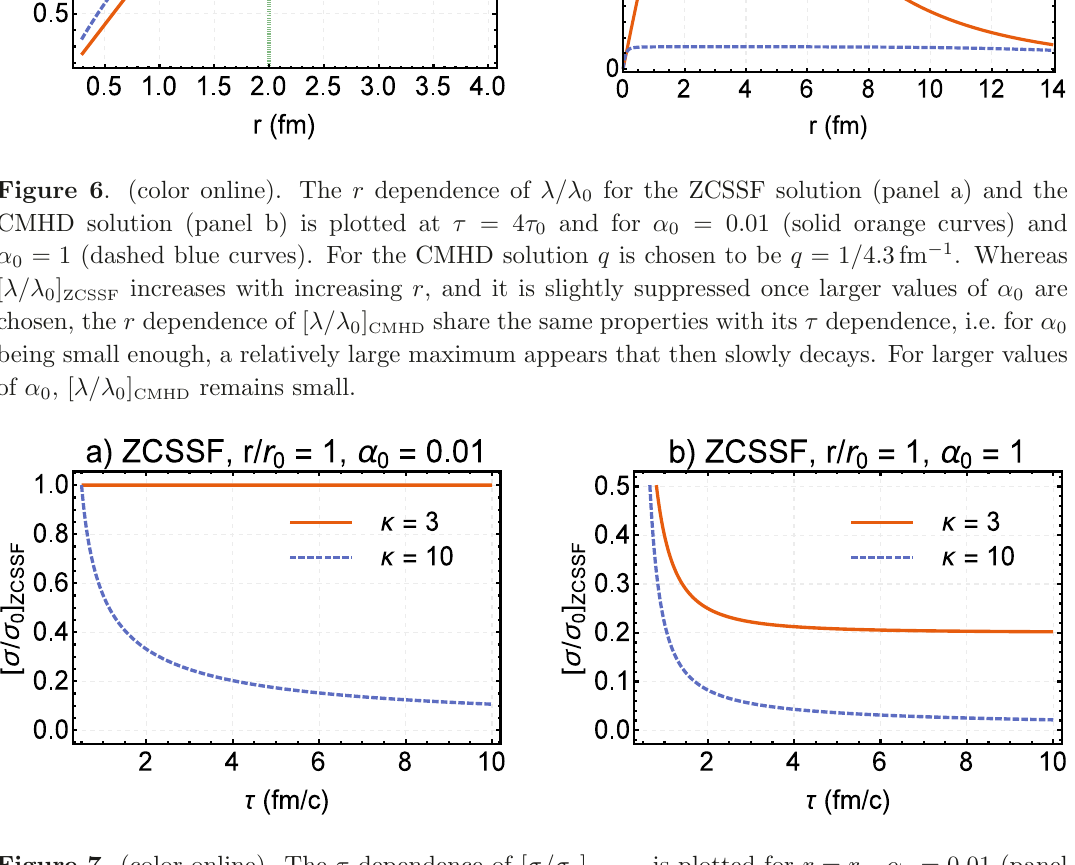
Figure 7 . (color online). The τ dependence of [ σ/σ 0 ] ZCSSF is plotted for r = r 0 , α 0 = 0 . 01 (panel a) and α 0 = 1 (panel b) as well as different values for κ = 3 (solid orange curves) and κ = 10 (dashed blue curves). For small values of α 0 , [ σ/σ 0 ] ZCSSF remains almost constant for κ = 3, that characterizes the conformal EOS. For a smaller speed of sound, e.g. κ = c − 2 s = 10, [ σ/σ 0 ] ZCSSF decays as the system